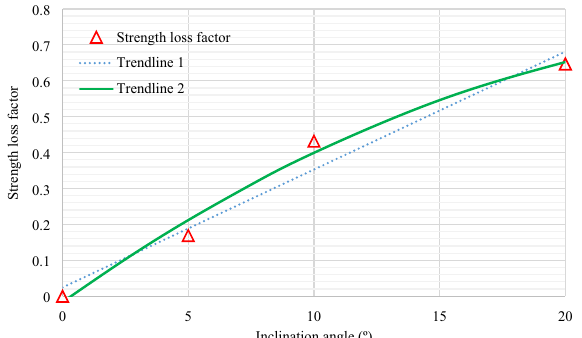
Figure 15. Effect of inclination angles on strength loss factor. Trendline 1 and Trendline 2 in Fig. 15 was fit against the data at an inclination angle range of 0° to